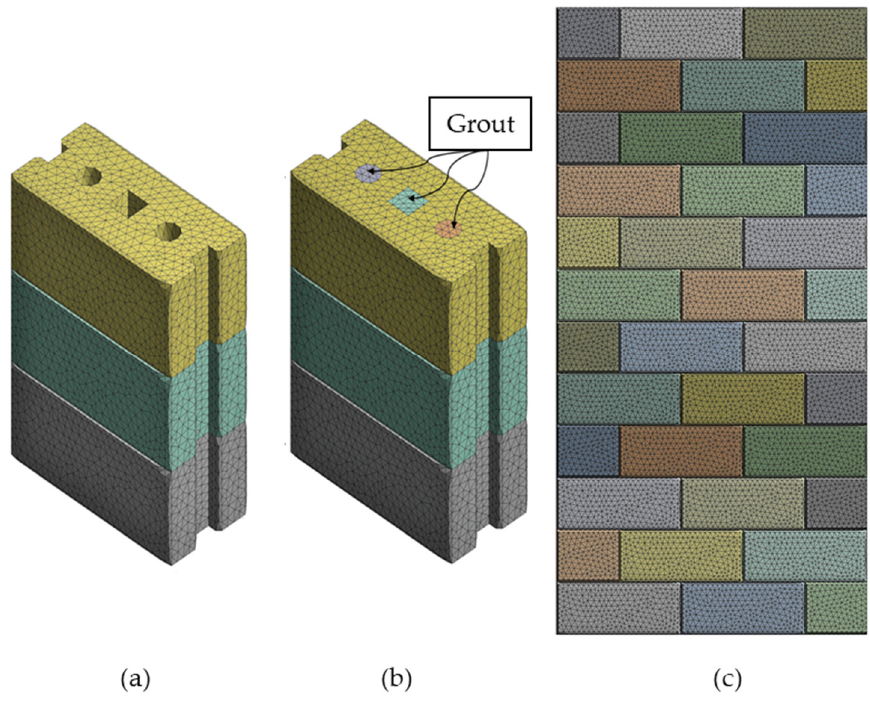
Figure 2. Mesh of the FE model of rubberized concrete interlocking masonry ( a ) hollow prism, ( b ) grouted prism, and ( c ) hollow wall.